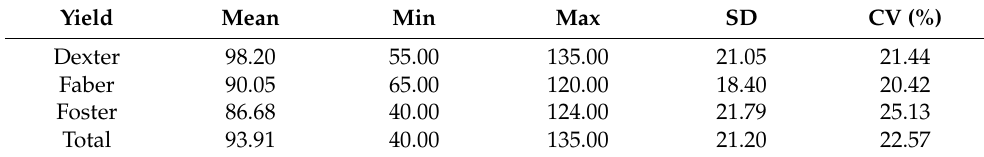
Table 3. Descriptive statistics of the yields (t/ha) corresponding to Dexter, Faber, and Foster hybrids. Yield Mean Min Max SD CV (%) Dexter 98.20 55.00 135.00 21.05 21.44 Faber 90.05 65.00 120.00 18.40 20.42 Foster 86.68 40.00 Total